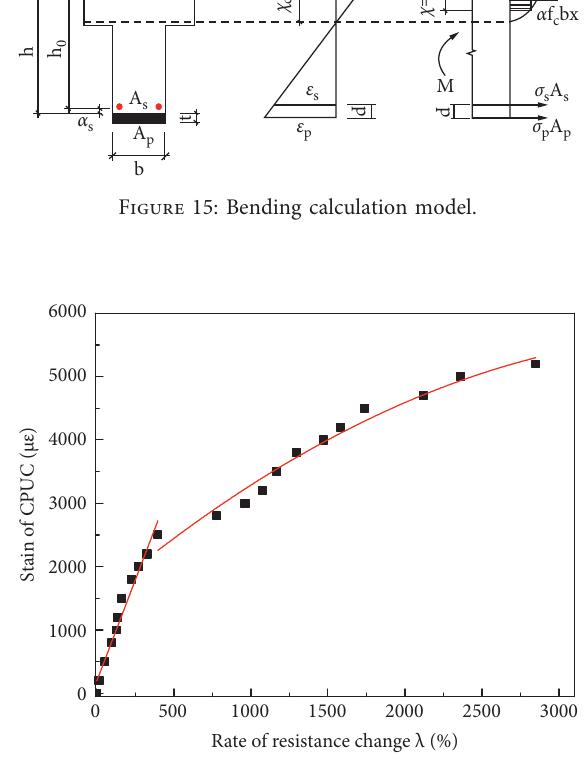
Figure 16: Diagram of fitting relationship between resistance change rate and strain.